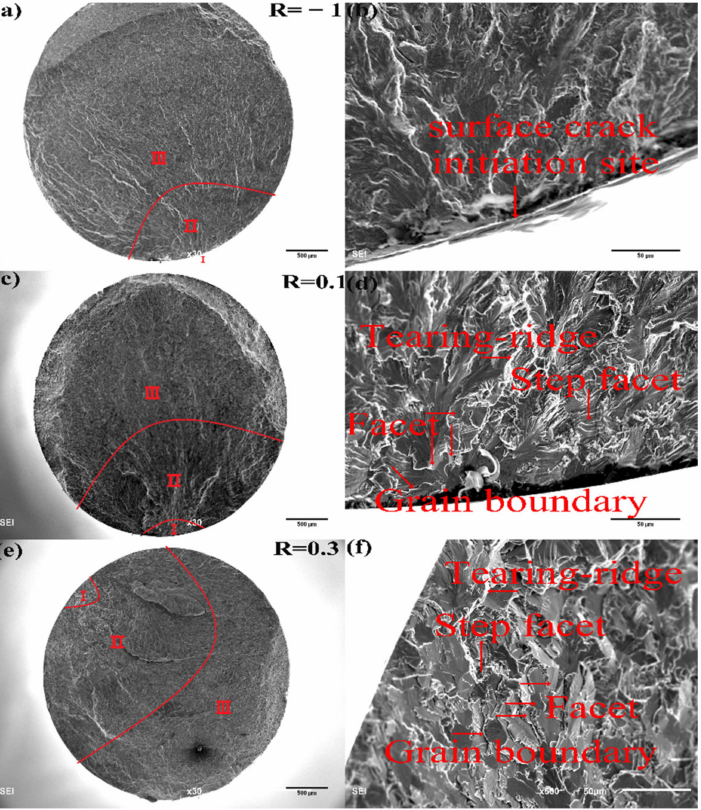
Figure 7. Fracture surfaces of specimens with surface crack initiation: ( a , b ) R = − 1, σ a = 460 MPa, N f = 1.77 × 10 7 cycles; ( c , d ) R = 0.1, σ a = 300 MPa, N f = 1.224 × 10 6 cycles; ( e , f ) R = 0.3 σ a = 148 MPa, N f = 1.687 × 10 7 cycles. I, II and III indicate the region I, II and III,